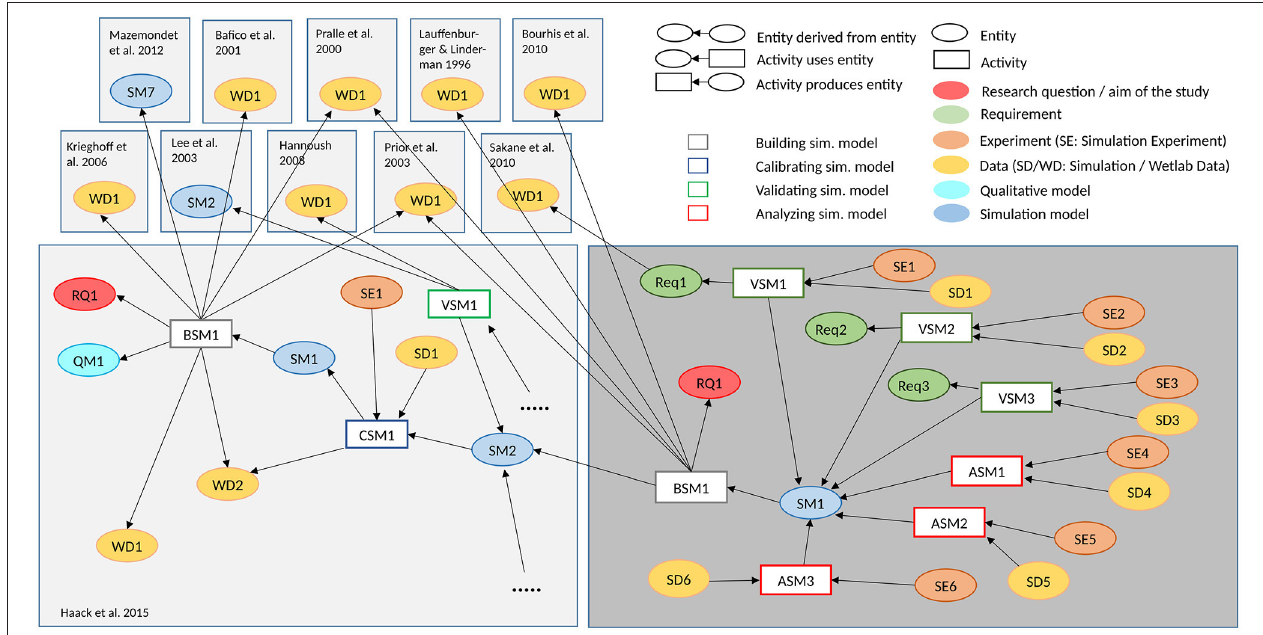
FIGURE 1 | Provenance graph of the conducted simulation study. The provenance graph shows central entities of the conducted simulation study, and what activities and other entities contributed to their generation, based on the provenance standard W3C-Prov ( Missier et al., 2013). The WNT simulation model (Haack et al., 2015) is adapted, to study how different numbers of lipid rafts influence LRP6 phoshorylation and β -catenin accumulation (Research question RQ1). The model building activity takes wet-lab measurements from various sources into account. Several validation experiments are executed. It is checked whether the ratio of LRP6 within and outside of lipid rafts (Requirement Req1) as described by Sakane et al. (2010) is still valid in the new model (Validating Simulation Model VSM1), whether the WNT concentration is not affected by increasing the number of lipid rafts (Req2 and VSM2), and whether the β -catenin remains constant (Req3 and VSM3), if the membrane model is decoupled from the intra-cellular model. Afterwards parameter scans, in which the number of lipid rafts varies between 1 and 30,000 with low (Analyzing Simulation Model ASM1), medium (ASM2) and high concentration of WNT (ASM3), respectively, are executed to analyse the impact on LRP6 phosphorylation and β -catenin (see Figure 3 ). The entities can be found in our git repository 1 https://git.informatik.uni-rostock.de/mosi/receptor-raft-ratio-model. The provenance graph also illuminates the relation to the earlier simulation study ( Haack et al., 2015) (for more detailed provenance of this and other WNT signaling models see Budde et al.,